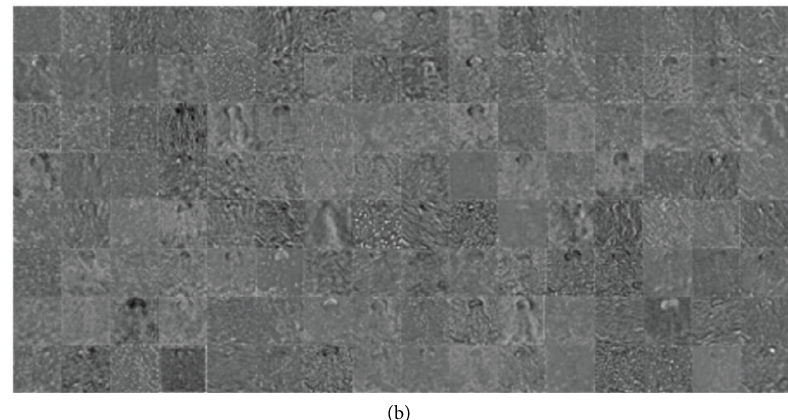
Figure 11: Feature images of res3a and res3b. (a) Feature images of res3a (128 images); (b) feature images of res3b (128 images).